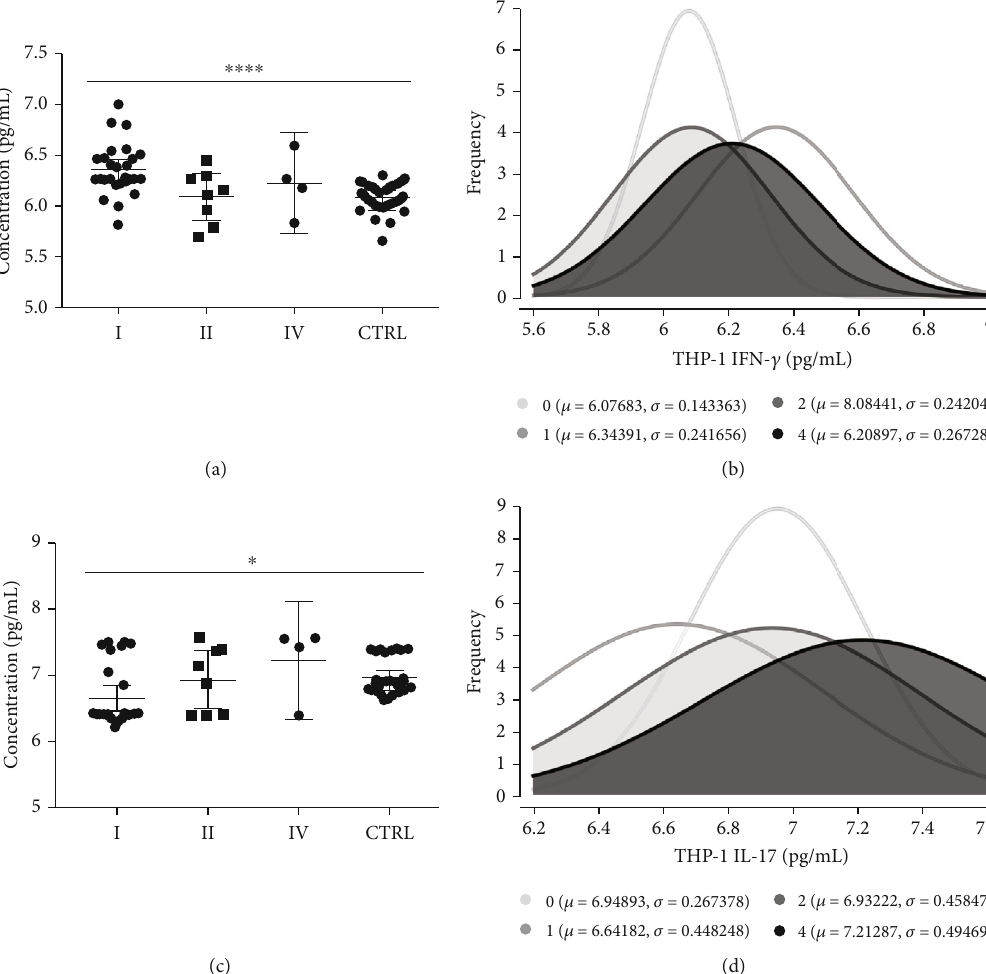
Figure 7: Cytokine production by THP-1 cells (macrophages) quanti fi ed in the supernatant by ELISA after 24h of stimulation with CCD or CTRL EVs among patients grouped based on NYHA functional classi fi cation and controls. (a) IFN- γ concentration in pg/mL ( ∗∗∗∗ p = 0 : 0001 ). (b) Frequency of IFN- γ concentration values (0: CTRL). (c) IL-17 concentration in pg/mL ( ∗ p = 0 : 0125 ). (d) Frequency of IL-17 concentration values (0: